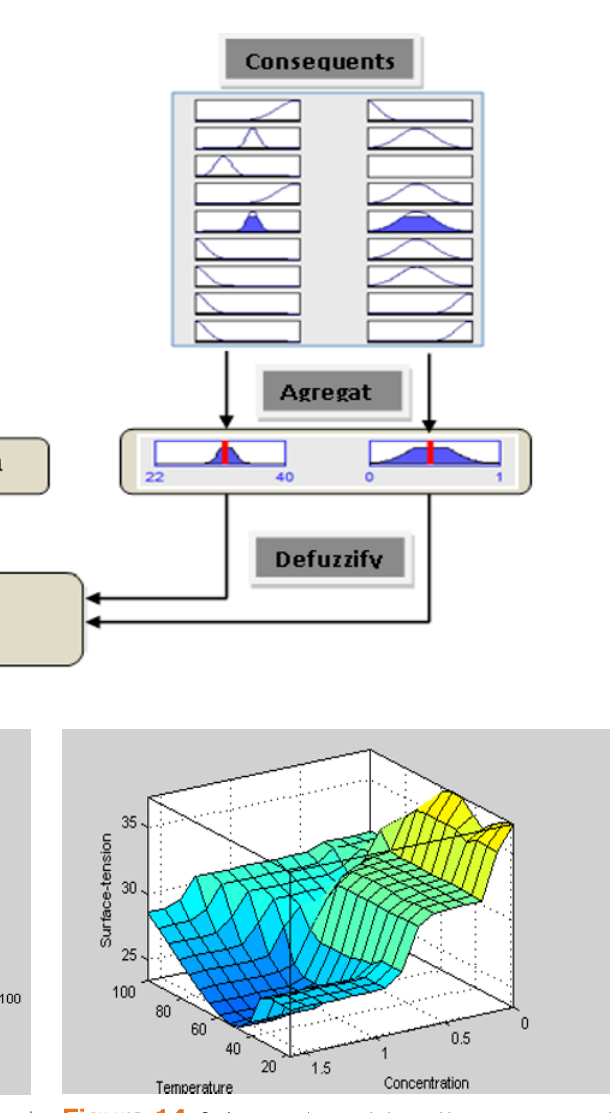
Figure 14. Surface tension variation with temperature and